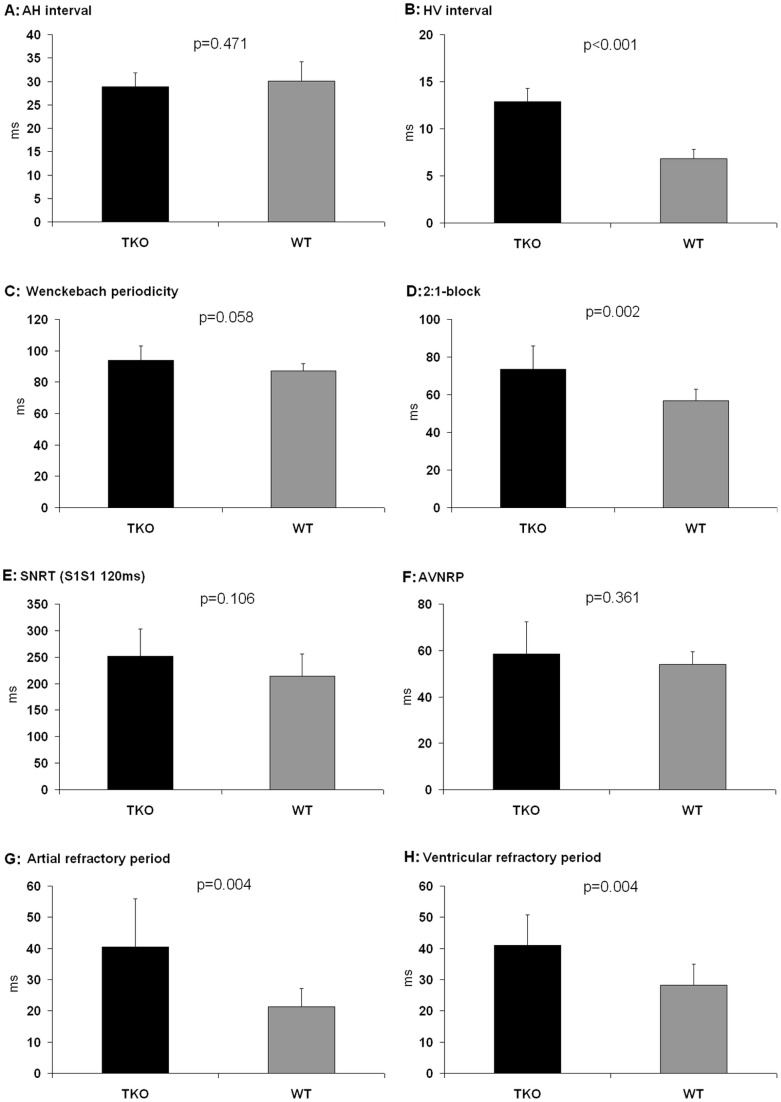
Intracardiac ECG parameters and functional testing during the electrophysiological investigation.Significant differences were found in the infra-Hisian conduction that was markedly delayed in TKO (B). The 2∶1-AV-block occurred at significantly slower fixed atrial pacing cycle lengths in TKO (D). Both the atrial and the ventricular refractory period demonstrated significant prolongation in TKO (G–H). AH: Interval from first atrial signal to His signal. HV: Interval from His to first intracardiac ventricular signal. 2∶1-block: 2∶1-AV-nodal-block. SNRT: sinus node recovery time. AVNRP: AV nodal refractory period. n = 10 for TKO and n = 10 for WT.